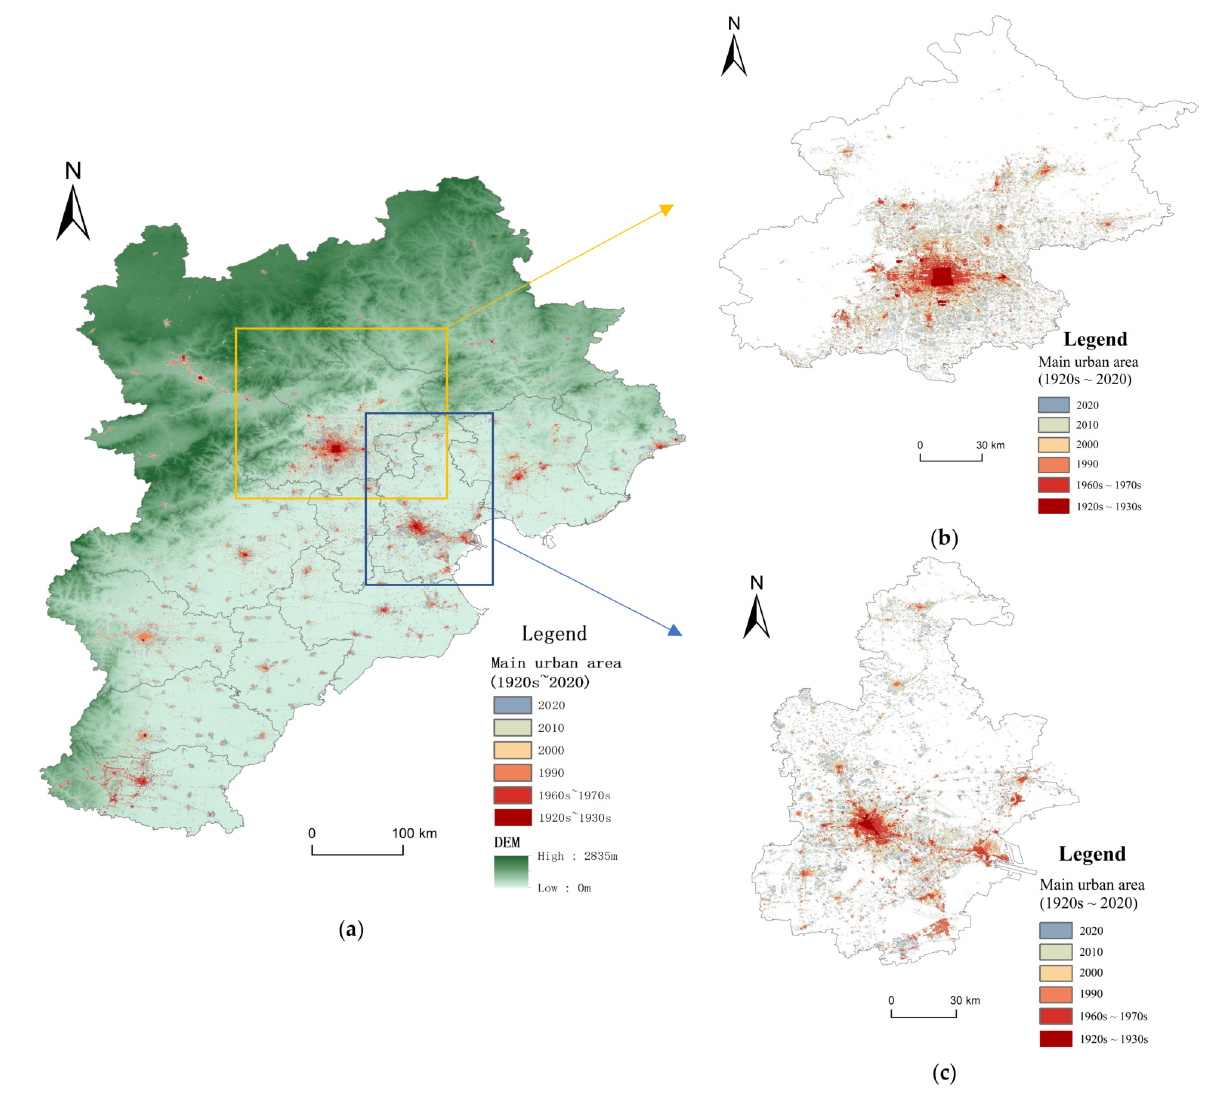
Figure 5. The reconstruction result of urban built-up area: ( a ) BTH region (yellow for Beijing and blue for Tianjin); ( b ) Beijing; ( c )